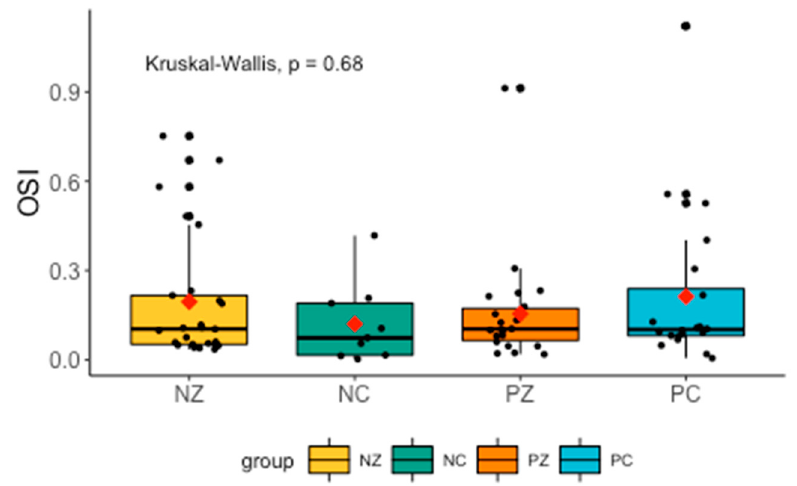
Figure 3. Levels of OSI in the saliva of the examined women. OSI, oxidative stress index; NZ, generally healthy patients without the BRCA1 mutation; NC, patients with breast cancer but without the BRCA1 mutation; PZ, generally healthy patients with the BRCA1 mutation; PC, patients with both breast cancer and the BRCA1 mutation.